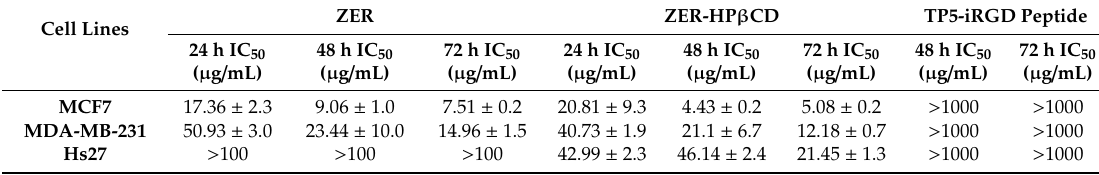
1. Inhibitory concentration (IC) 50 of zerumbone (ZER), ZER-hydroxypropyl- β -cyclodextrin(HP β CD) and TP5-iRGD peptide. Cell